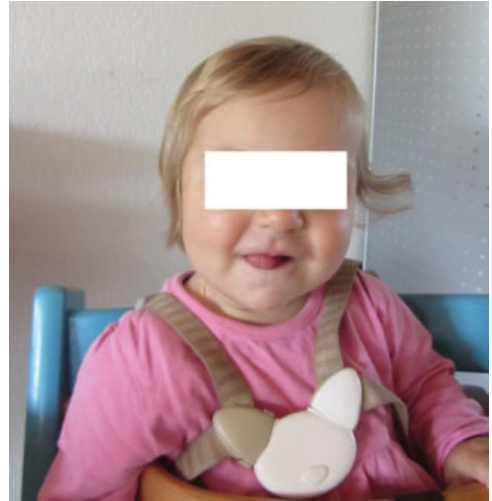
Fig. 3 Photograph taken 6 months after the operation. Straight hair is visible on the right side of the head. The right side of the head is affected by Horner ’ s syndrome. The original hair texture of the infant is retained on the left side of the head.